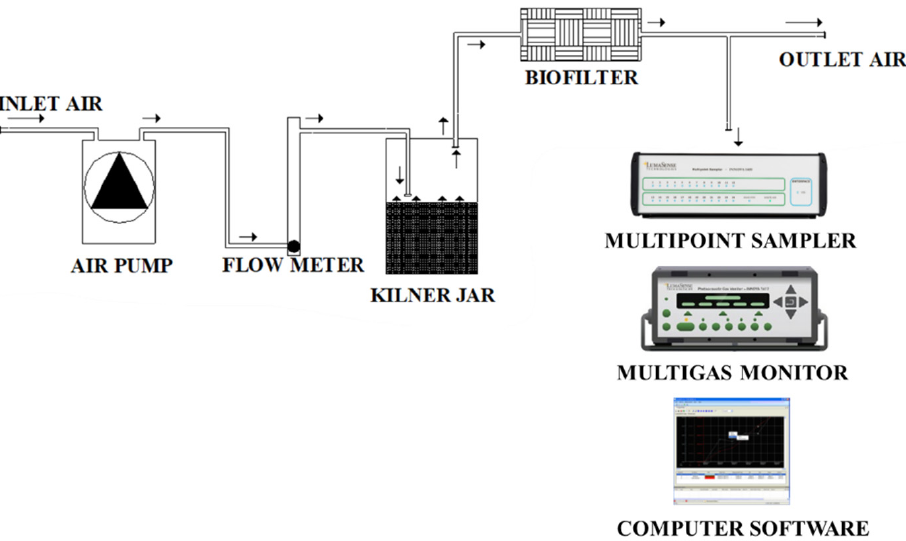
Figure 1. Schematic view of the laboratory system developed by Pereira et al. [31] and used in this